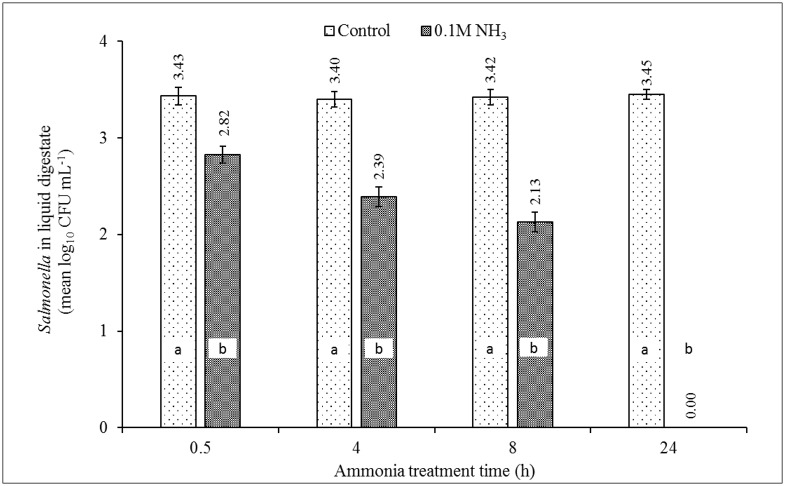
The effect of MIC of ammonia (0.105 M NH3; the equivalent of 1,468 NH3-N mg/L) on inactivation of ST4232 in digestate of week #3 of poultry carcass aerobic digestion.Source of NH3 was (NH4)2SO4. The control contained only residual TAN (0.039 M) in the digestate collected at week #3 [24]. Week #3 represents an early-phase of decomposition characterized by high BOD, highest TSS & VSS levels, and the first visual evidence of the whole carcass breakup and disintegration. Data represent the means log10 of measured Salmonella concentrations of 4 aerobic reactors ± SD. Different letters in each treatment time indicate significant difference (p<0.05), n = 3.